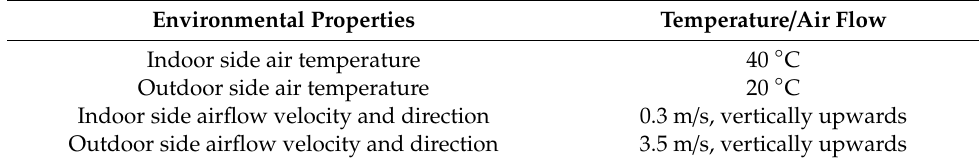
Table 3. Simulated micro-environment conditions.